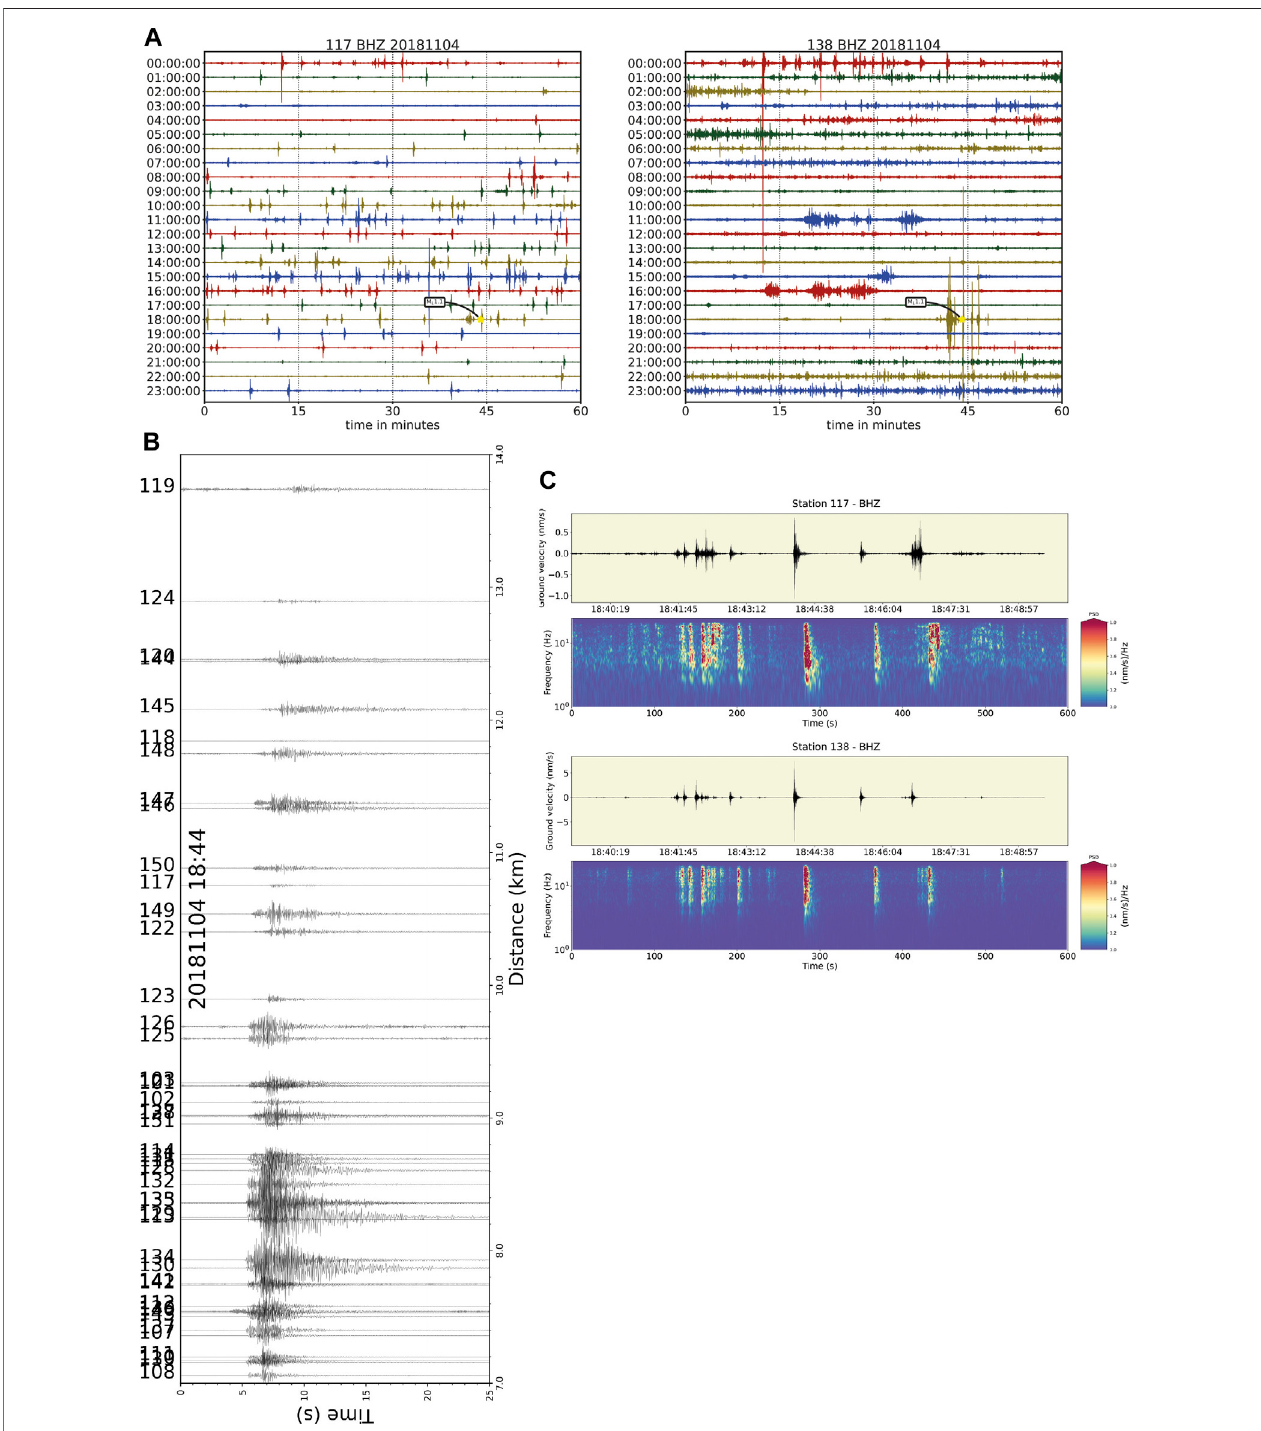
FIGURE 7 |(A) Day-plots for 4 November 2018 are shown side by side for stations 117 and 138. The M L 1.1 earthquake that occurred at 18:44 UTC southwest of Lipari Island and ∼ 8 km away from Vulcano is also shown (more details in the text). (B) Record section of the M L 1.1 event. Distance scale is exaggerated to improve the visualization. (C) Groundvelocities(topofeachsubplot)andspectrograms(bottom)ofthe4November2018eventat117and138.Spectrogramsarecomputedusinga 2 s window length for the fft with 80% overlap.